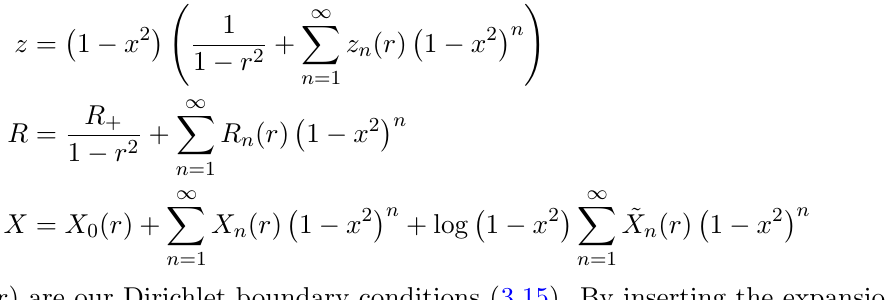
Figure 2. The maximum value of (cid:24) 2 for two choices of R (cid:0) =R + in d = 4 (circles), d = 5 (squares), and d = 6 (triangles). Our numerical method leads to exponential convergence in the number of grid points, N , until saturation. Even boundary dimensions ( d = 4 and 6) show more numerical error because of the presence of logarithmic terms in the asymptotic expansion (see equation (4.1).) To do so, we